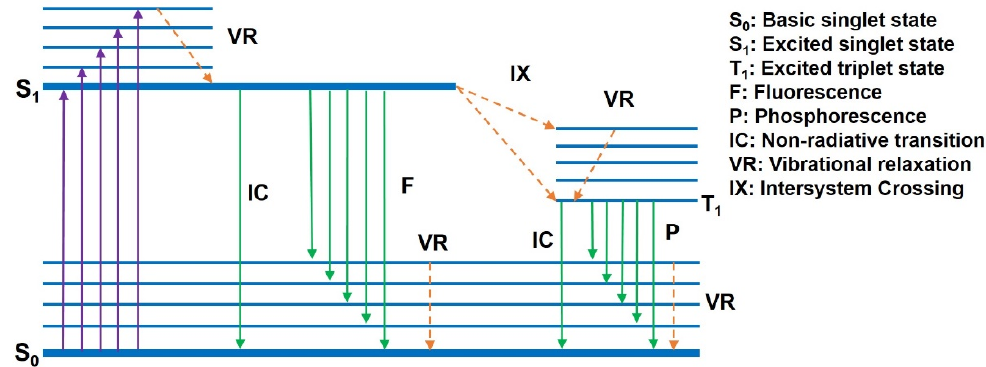
Figure 2. Schematic diagram of radiative transition for typical conjugated polymer materials.